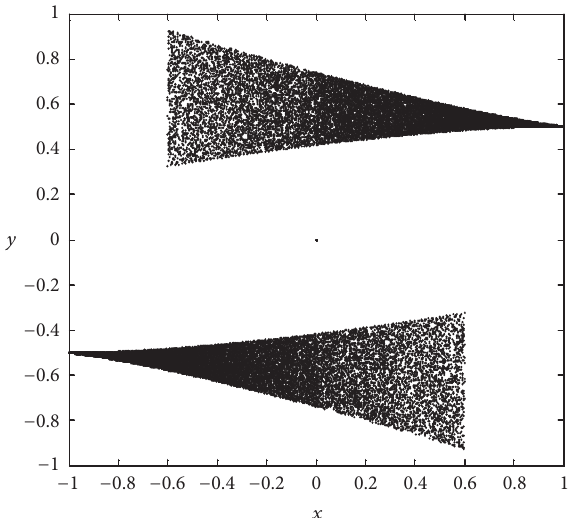
Figure 3: Graph of 𝐹(𝑈) while 𝜇 = 1 , 𝑢(𝜇) = 0.5 , 𝐴 = −1.6 , ] = 0.9 , = 0.1 , 𝑎 = 0.3 , and 𝛾 = 1.2 . 𝑎 21 22